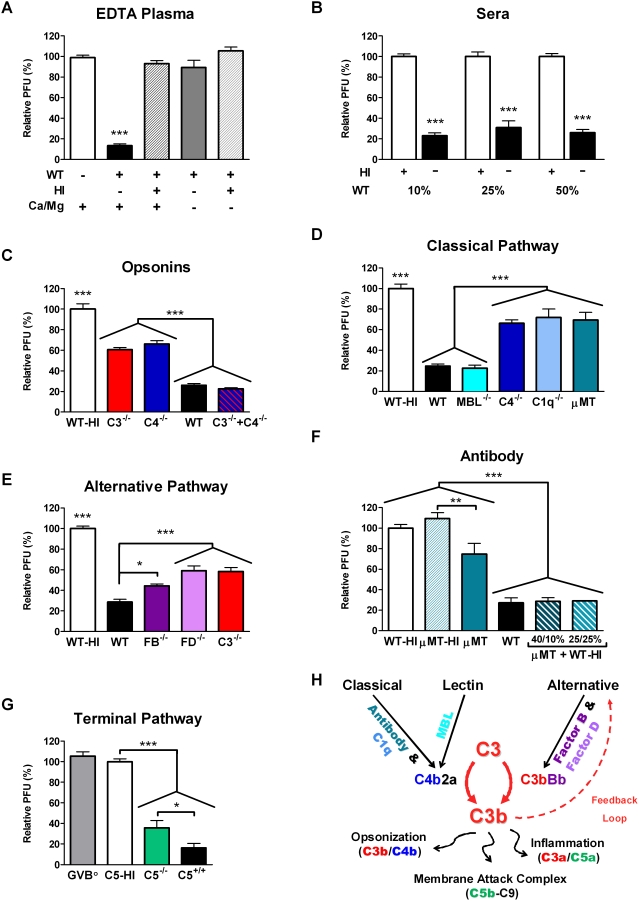
The murine complement system neutralized ECTV virions.(A–G) ECTV was incubated with a mouse complement source at 37°C for 1 hour and then added to BSC-1 monolayers. The absolute number of plaques was normalized to the appropriate controls (white bars) to give the relative number of plaques. Graphs display mean±SEM from multiple experiments. All data were analyzed using 1-way ANOVA followed by the Tukey multiple comparison test except (B), which used a 2-way ANOVA to analyze concentration and activity. (A) Mouse plasma neutralizes ECTV. ECTV was combined with 10% wild-type (WT) mouse EDTA-treated plasma or heat-inactivated (HI) plasma in gelatin veronal buffer (GVB) in the presence or absence of calcium and magnesium (Ca/Mg). The active plasma (in the presence of Ca/Mg) differed from all other groups (***, P<0.001). These data were combined from nine independent experiments using EDTA plasma collected on three separate days. The total number of replicates for each column from left to right follows: n = 25, 29, 17, 7, 3. (B) Mouse serum neutralizes ECTV. ECTV was incubated with increasing concentrations of HI (white) or active (black) WT mouse sera. Data represent three to four independent experiments performed in duplicate with four different collections of sera. Active sera neutralized ECTV (***, P<0.0001), at multiple concentrations. (C–G) The relative roles of the complement pathways were analyzed using sera from mice genetically deficient in complement components (C3, C4, C1q, MBL A and MBL C, FB, FD, or C5) or antibody (μMT). A final concentration of 50% sera was used in all cases. Data were combined from at least two experiments performed in duplicate with independent collections of sera. Unless noted specifically below, the significant differences are displayed on the graph as follows: *, P<0.05; **, P<0.01; ***, P<0.001. Any significant differences among grouped bars are noted on the graph. (C) C3−/− or C4−/− sera have reduced neutralizing capacity. Combining C3−/− and C4−/− sera restored neutralizing activity to WT levels. WT-HI differed from the other conditions (***). Data were from at least three experiments performed in duplicate. (D) Deficiencies in the classical pathway (C4, C1q) and antibody (μMT), but not the lectin pathway (MBL), reduce neutralization. WT-HI differed from C1q−/− (P<0.01) and differed from the rest of the conditions (P<0.001). Data were from at least two experiments performed in duplicate. (E) Neutralizing activity requires the alternative pathway components: FB, FD, and C3. WT-HI differed from the other conditions (***). Data were from at least two experiments performed in duplicate. (F) Addition of either 10% or 25% WT-HI sera restores the neutralizing activity of antibody-deficient μMT sera to WT capacity. Heat inactivation of μMT sera reduces neutralization. Data were from two experiments done in duplicate. (G) MAC (C5b-9) formation enhances neutralization but is not required. Both the C5+/+ and C5−/− sera had greater neutralization than HI-C5+/+. The buffer only control (GVB°) is equivalent to WT-HI. Data combined from three experiments performed in triplicate. (H) The classical, lectin, and alternative pathways each initiate the complement cascade by forming a C3 convertase that cleaves C3 to C3b. Antibody triggers the classical pathway through C1q. The carbohydrate motifs on pathogens activate the lectin pathway through MBL. The classical and lectin pathways form the C4 containing convertase, C4b2a. C3 deposited from these two pathways or from spontaneous activation of C3 initiates the alternative pathway. Upon binding, the activated C3 molecule FB is cleaved to Bb by FD, which forms the alternative pathway convertase, C3bBb. The alternative pathway amplifies C3b deposition by any pathway. C3 activation leads to important antiviral effector functions. Release of the anaphylatoxins C3a and C5a recruits inflammatory cells. C3b and C4b opsonize viral particles or infected cells, leading to neutralization or destruction by phagocytosis. C3b also leads to activation of C5 and formation of the MAC which disrupts virions or infected cells.